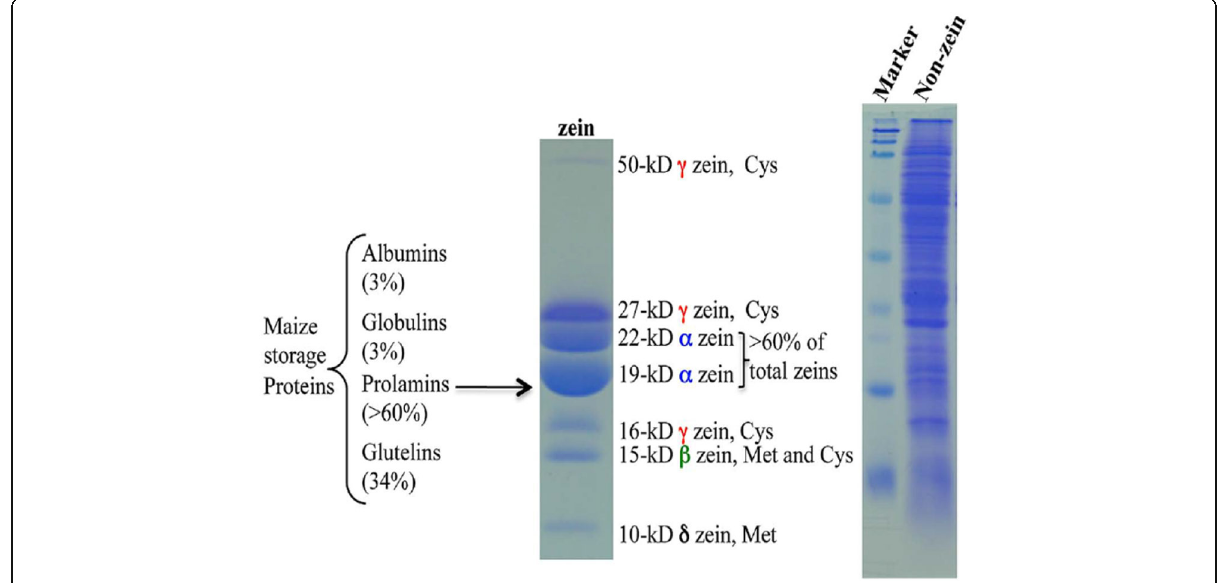
Fig. 2 Maize storage proteins. Prolamin proteins in maize are called zeins and the others are all classified as non-zeins. Adapted from Wu et al.